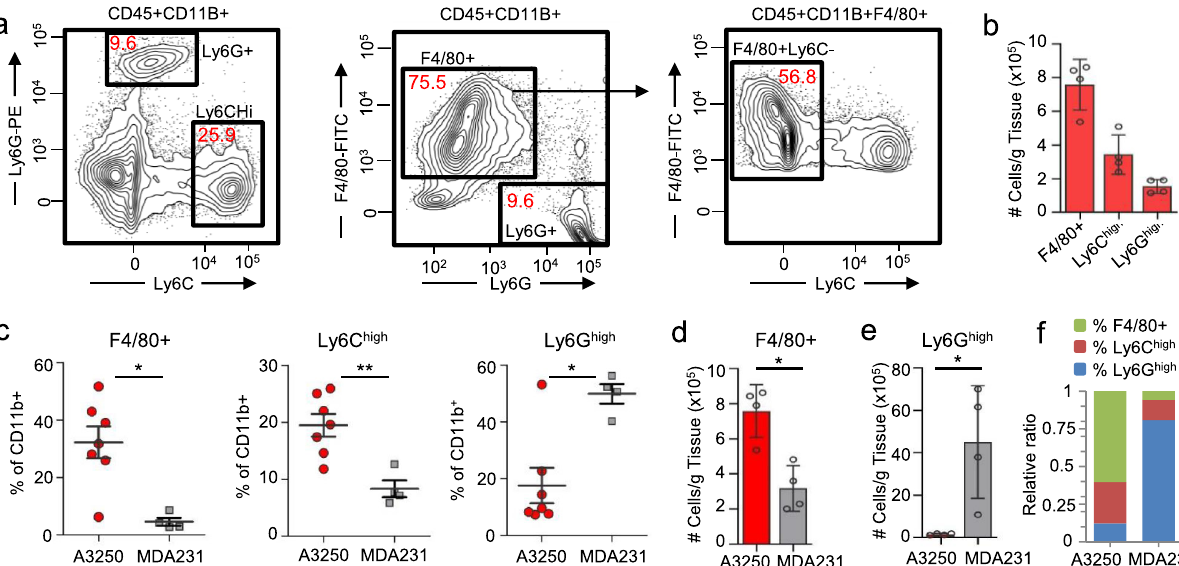
Fig. 5 In fl ammation associated with A3250 tumors by FACS analysis. a Gating strategy used to characterize myeloid cell populations in A3250 tumors. Numbers in red indicate percent of total CD45 + CD11b + cells. b Quanti fi cation of different myeloid cell subsets in A3250 tumors at four weeks ( n = 4). c Comparison of the frequency of myeloid cell subsets in A3250 ( n = 7) and MDA-MB-231 ( n = 4) tumors at 4 weeks as indicated. To control for repeated measures, a Linear Mixed Model fi t by REML and t test using Satterthwaite ’ s method was used for analysis (%F4/80 + : p = 0.015927, %Ly6C high : p = 0.00625, %Ly6G high : p = 0.0205). Quanti fi cation of F4/80 + macrophages ( d ) and neutrophils ( e ) in A3250 ( n = 4) and MDA-MB-231 ( n = 4) tumors. Two-tailed Mann – Whitney t test yielded p = 0.0286 ( d ) and p = 0.029 ( e ). f Relative ratios of different myeloid cell populations in tumors as indicated. On the charts, mean ± SEM is indicated.** p < 0.01, * p < 0.05. Source data are provided as a Source Data fi